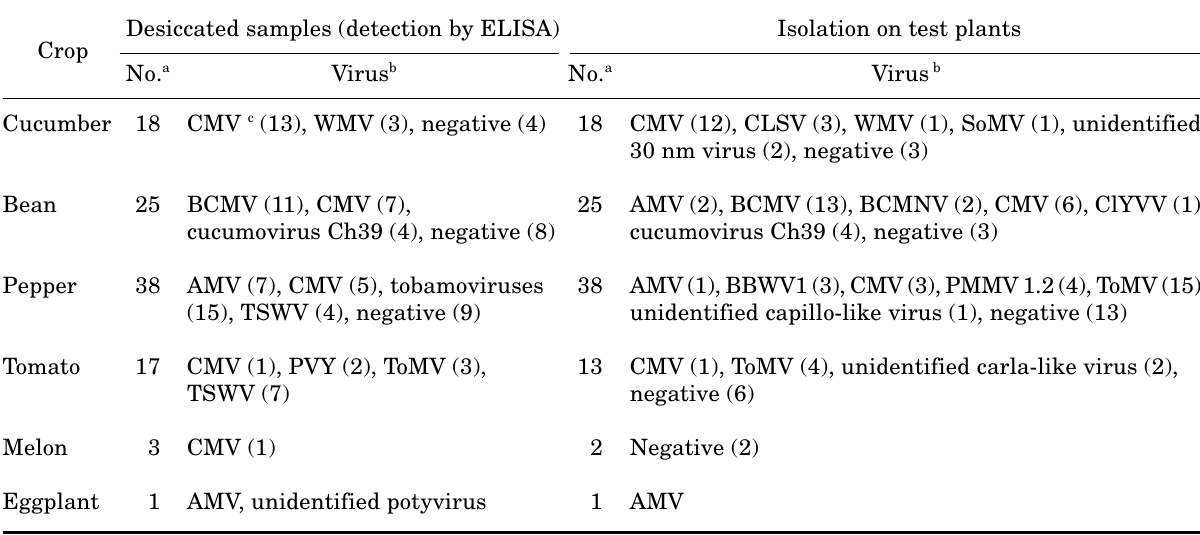
Table 2. Viruses detected in 1999 in the desiccated field samples by ELISA and recovered on experimentally infected plants. Several samples were infected with two